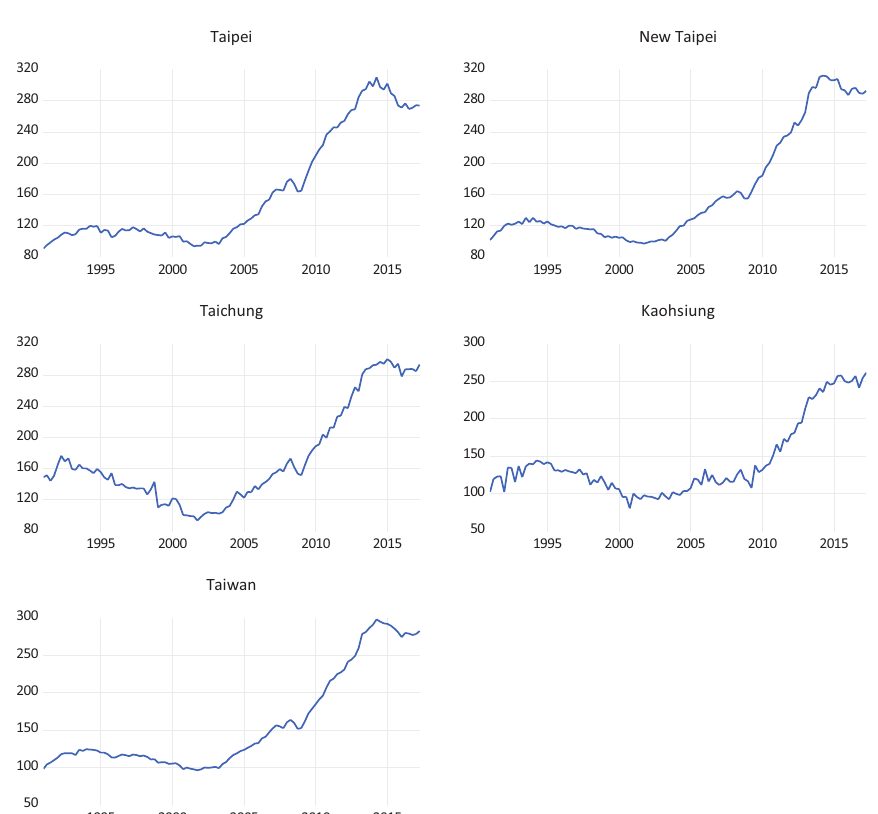
Figure 2. Housing price